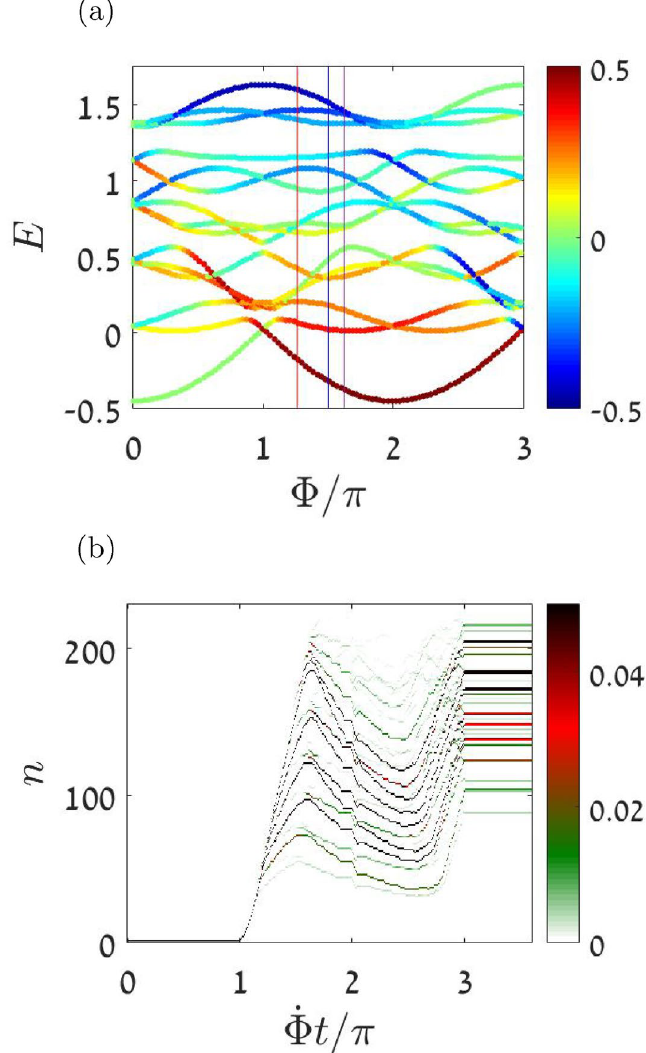
Figure 4. Quantum spreading in few particle system. Even for small number of particles the semiclassical perspective is useful. Upper panel: The many body energy levels E n for N 2.3 . The points are color-coded by the expectation value of M . Lower panel: The quantum function of (cid:31) for u = 30 particle ring is imaged. Each row is the color-coded probability p n evolution of N = a function of time. For larger N we expect a very good quantitative correspondence with the semiclassical simulations of Fig.